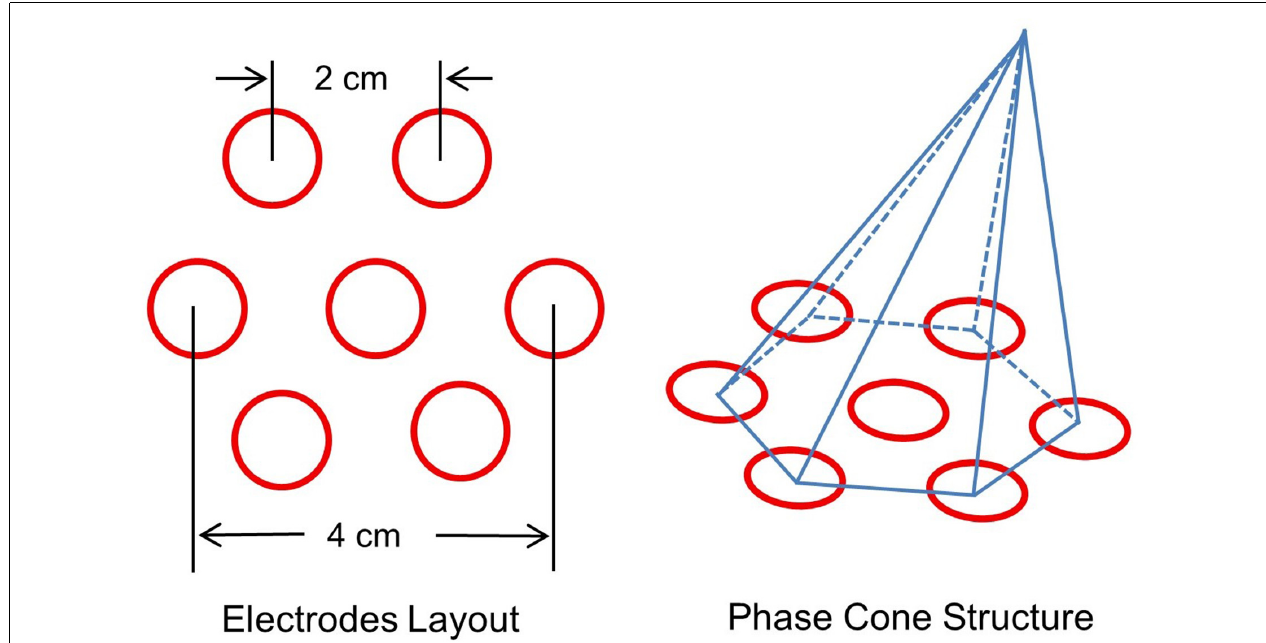
FIGURE 2 | (Left) Layout of a center electrode and six nearby electrodes, and (right) a schematic representation of the phase cone which arises due to the coordinated activity of cortical neurons at mesoscopic scales. The interelectrode separation is 2.0 cm.